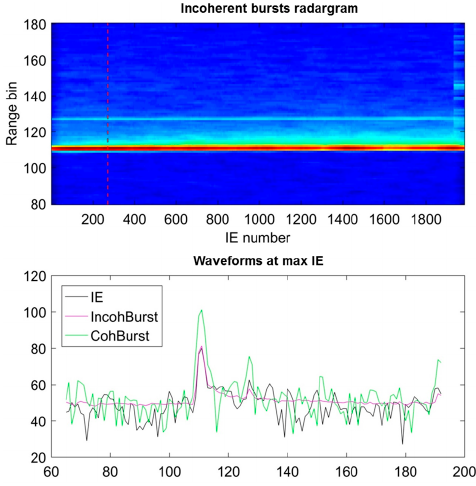
Remote Sens. 2017 , 9 , 605